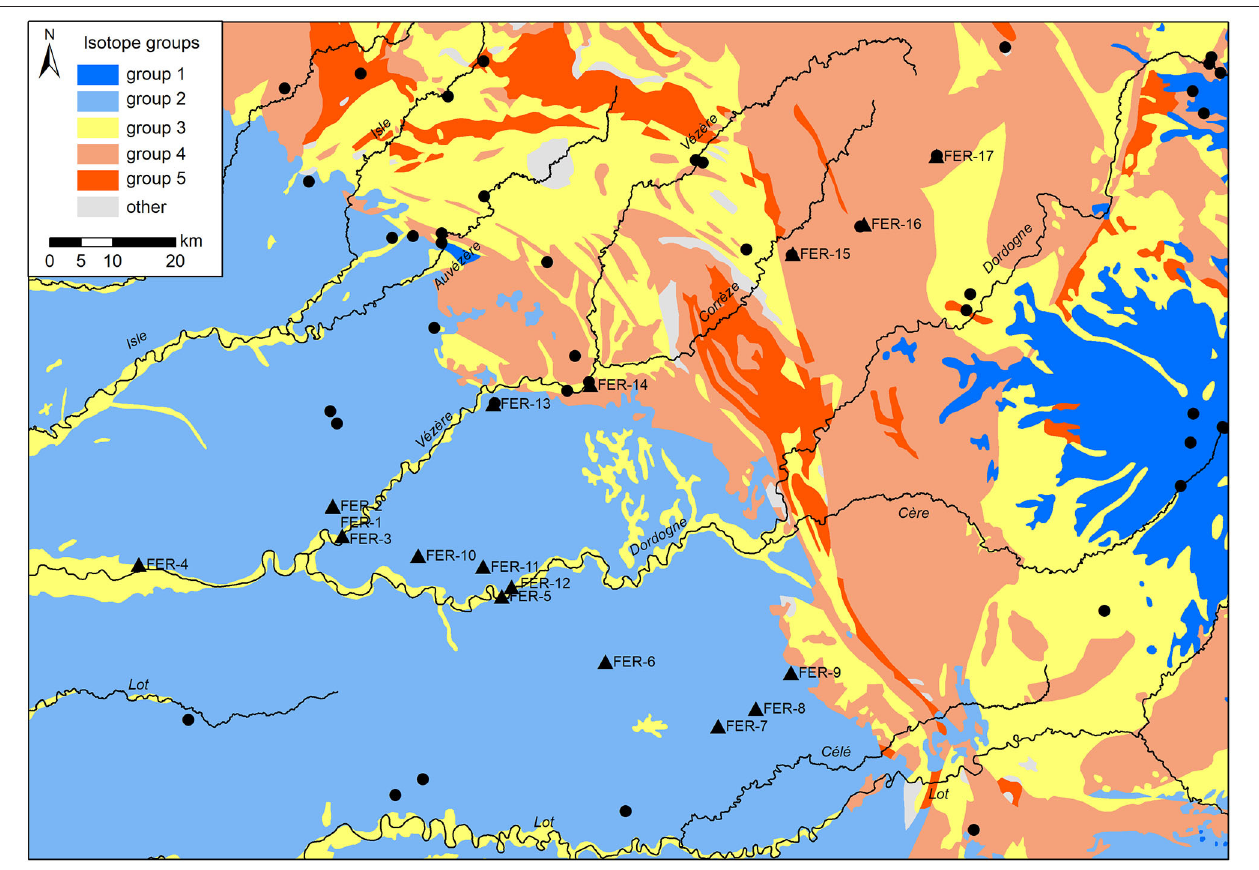
FIGURE 3 | Lithological units of the study area classified by isotopes groups (adapted from Willmes et al., 2018). Sampling locations of the study are indicated (black triangles) as well as IRHUM sampling sites (black circles).